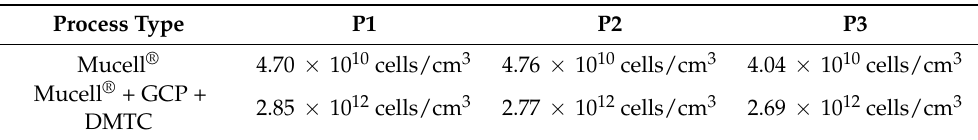
Table 11. Averaged cell density comparison between traditional MuCell ® and its simultaneous combination with GCP and